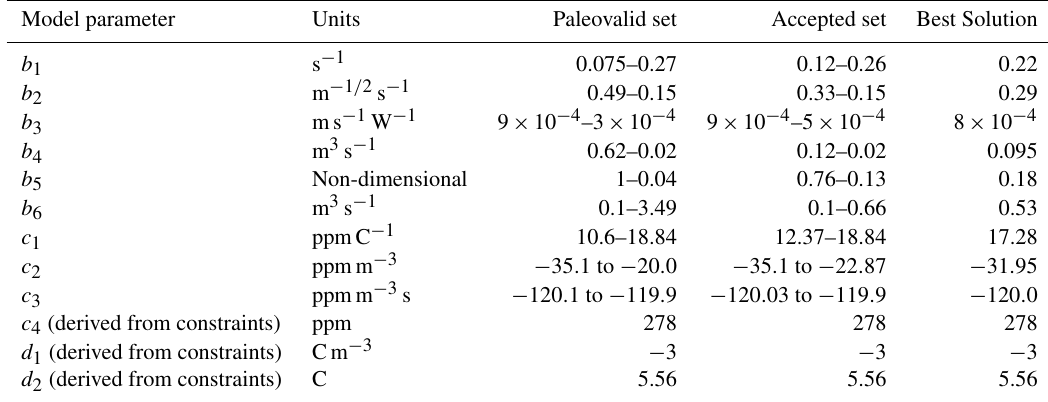
Table 2. Parameter ranges across solutions in the Paleovalid and Accepted sets as well as for the Best Solution. Model parameter